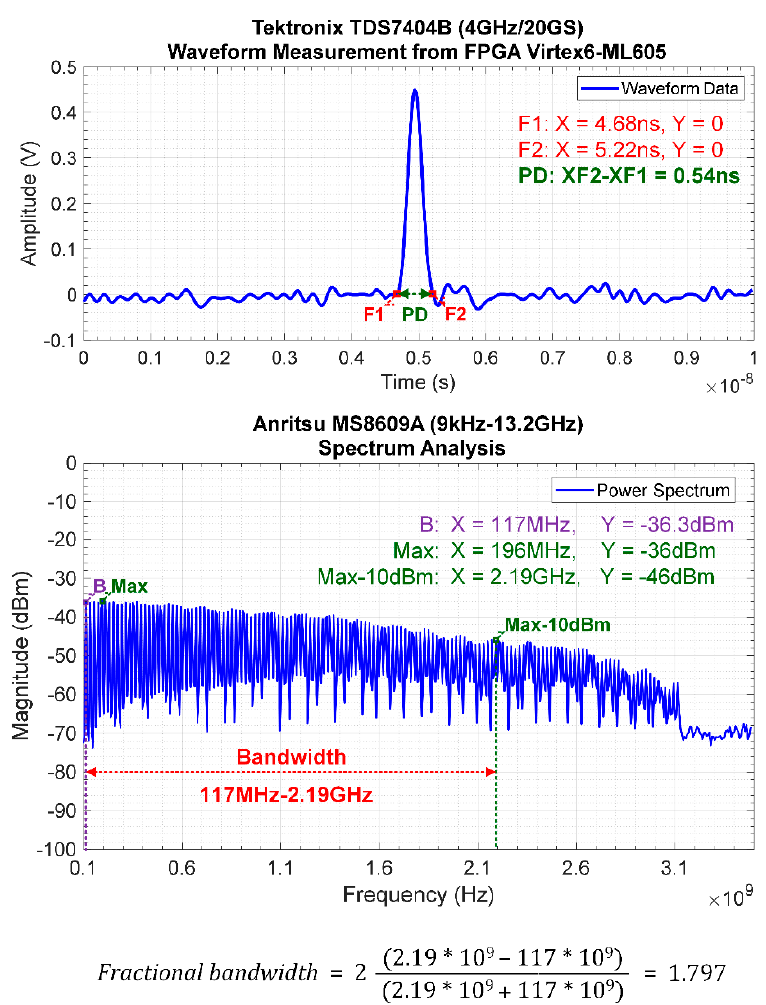
Figure 15. Pulse duration and bandwidth of IR-UWB generated by the FPGA scheme.